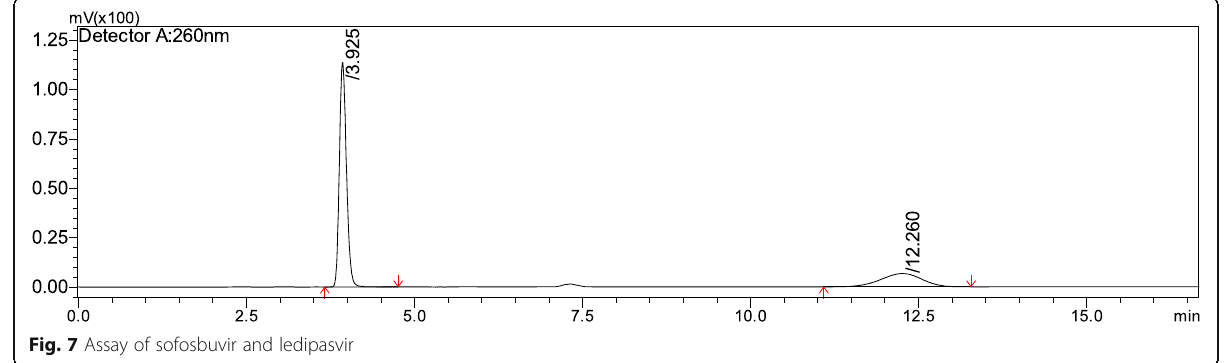
Fig. 7 Assay of sofosbuvir and